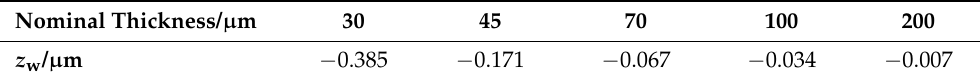
Table 1. The bending z w of cantilevers caused by their own weight calculated with Equation (4). Nominal Thickness/ µ m